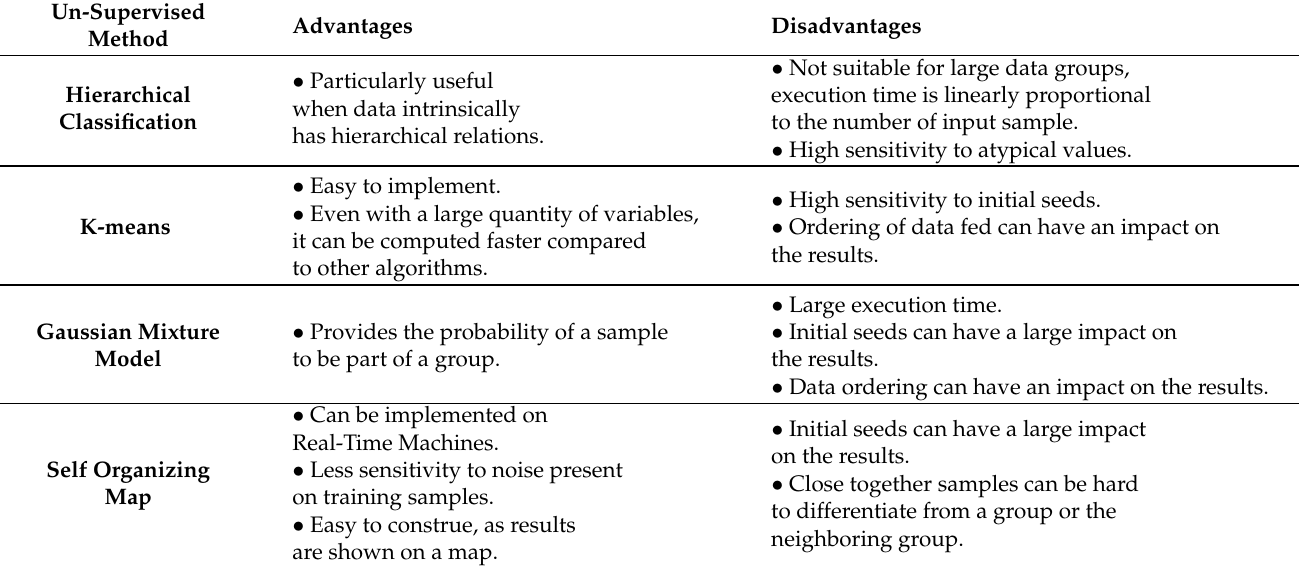
Table 2. Unsupervised methods in ML [33,35,36].